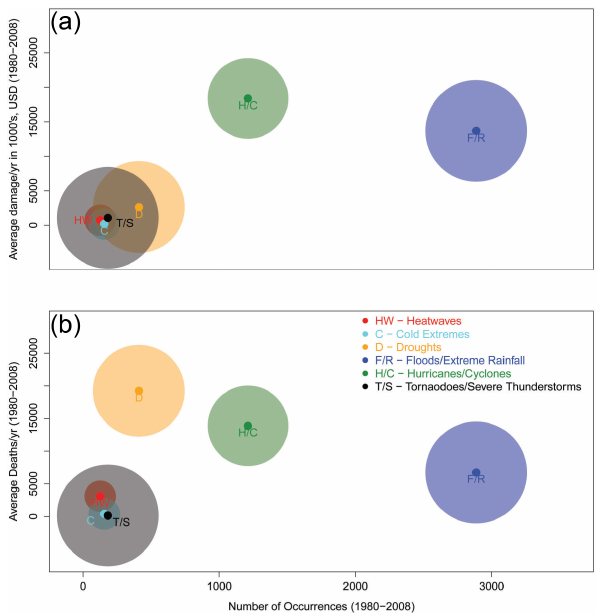
Figure 1. Frequency and severity of hydrometeorological hazards, indicated as damages in US dollars (a) and annual fatalities (b) , along with their uncertainties in our current understanding in a climate change context. Damage and fatality data are taken from the UN Office for Disaster Risk Reduction (UNISDR) at Preven- tionWeb (http://www.preventionweb.net/english/hazards/) averaged over 1980–2008. The uncertainties are represented by the size of the bubbles with larger circles indicative of greater uncertainty and are derived from the IPCC confidence and likelihood estimates (Field et al.,